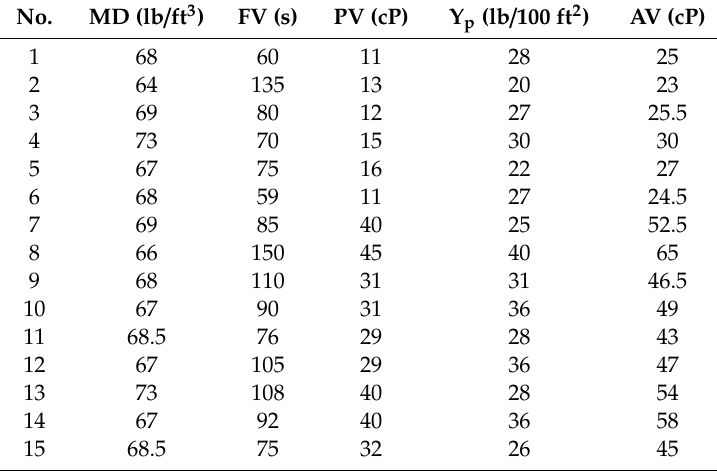
Table 4. Sample of the filtered HBM field